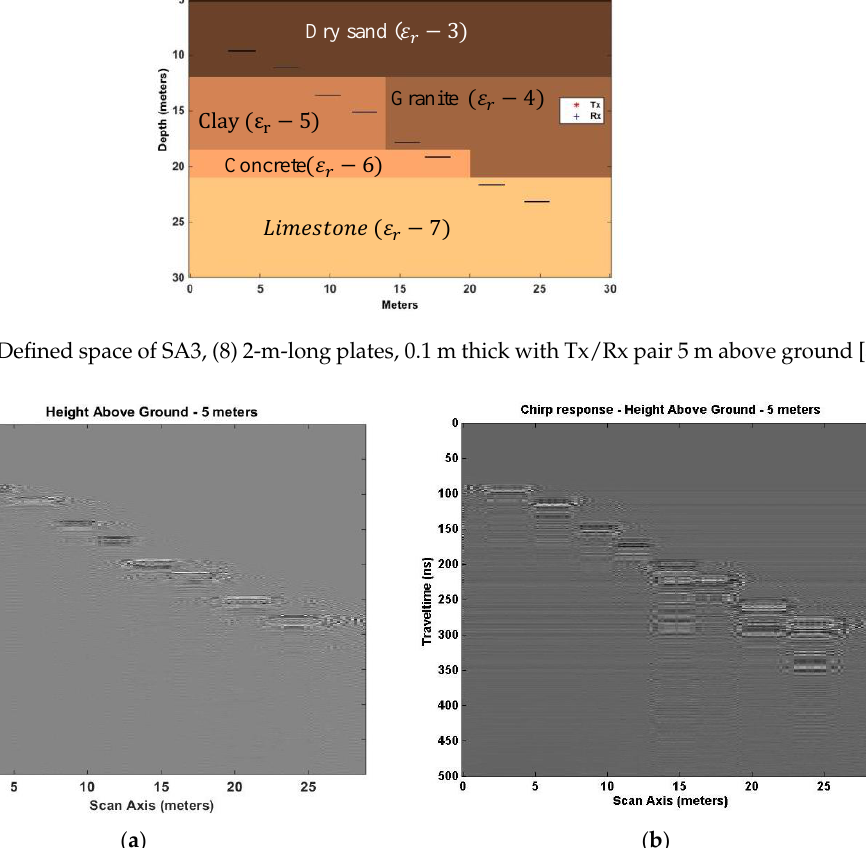
Figure 20. ( a ) Output response of SA3, EM sum of frequency signals with direct arrival and ground bounce signals removed with Tx/Rx pair 5 m above ground [5]. ( b ) Output response of SA3 model, chirp excitation function with the direct arrival and ground bounce signals removed with Tx/Rx pair 5 m above ground.